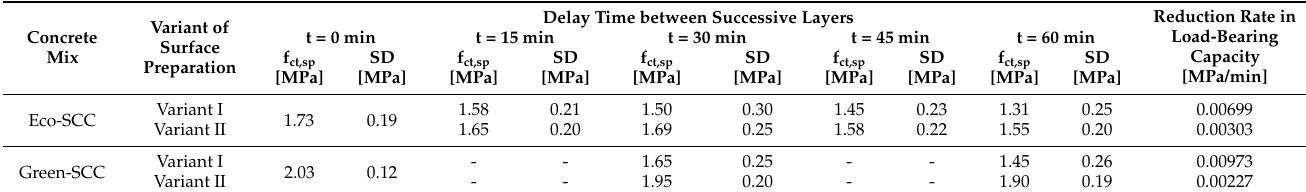
Table 4. Results of splitting tensile strength measurements on samples made of multiple concrete layers.